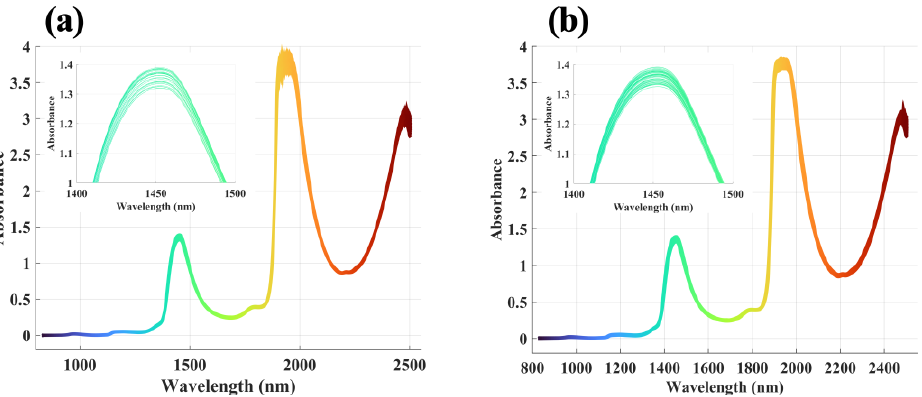
Figure 2. The NIR spectra of all LMWHA solution samples in the wavenumber range of 780 nm to 2500 nm. ( a ) Raw spectra; ( b ) Spectra after preprocessing with SG smoothing filter and